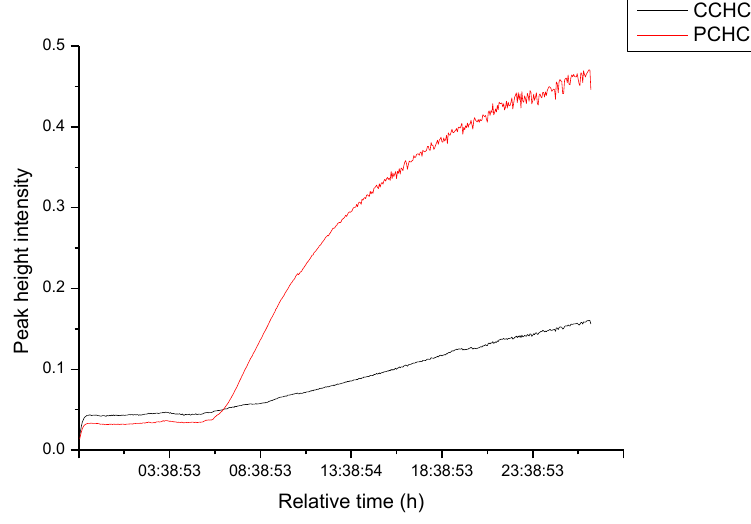
Figure 2. Representative plot of poly(cyclohexene carbonate) (PCHC) and cyclic cyclohexene carbonate (CCHC) formation as a function of time using catalyst 1 .